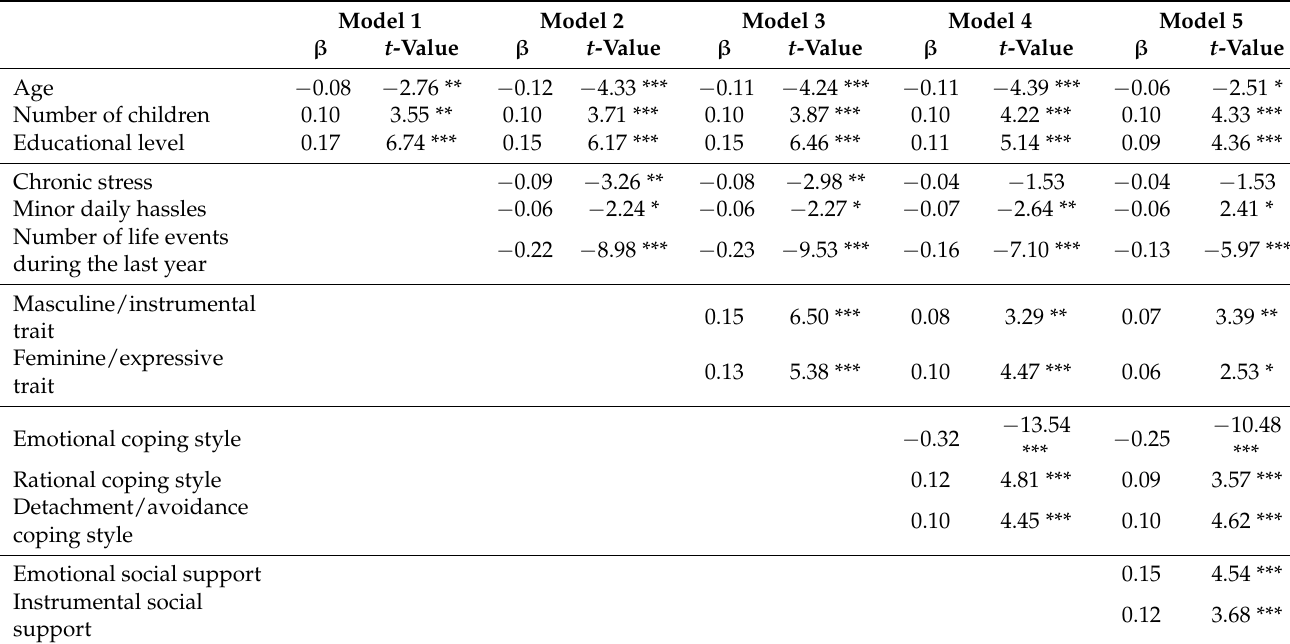
Table 7. Summary of the hierarchical regression with life satisfaction as the dependent variable for